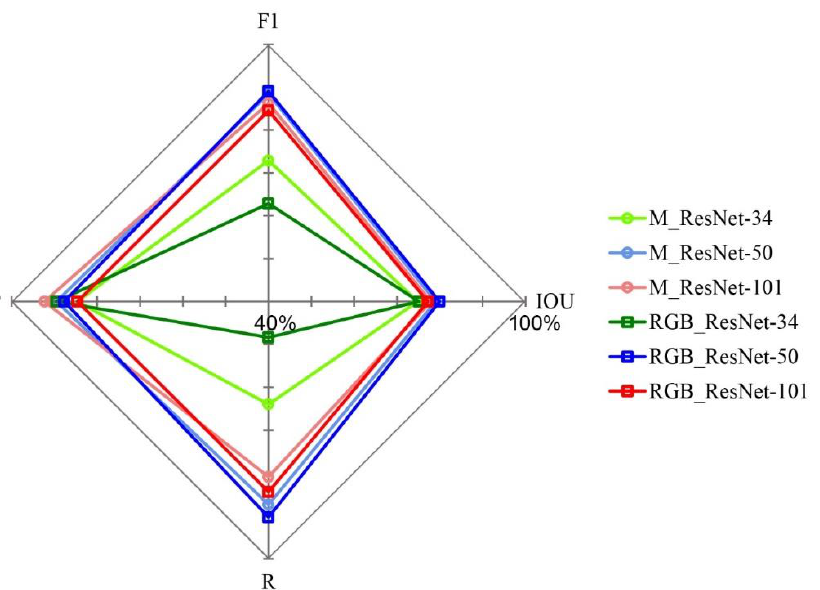
Figure 5. The detection accuracy of Fokienia hodginsii using Mask R-CNN with three different backbones (ResNet-34, ResNet-50, and ResNet-101). The same number of training samples (1689 tree crowns) and two input images (RGB image and Multi-band image) were used as input into the model, and other parameters were kept the same. The accuracy was achieved using ResNet-34 with the Multi-band image, which is highlighted in light green, ResNet-34 with the RGB image is in dark green, ResNet-50 with the Multi-band image is in light blue, ResNet-50 with the RGB image is in dark blue, ResNet-101 with the Multi-band image is in light red, and ResNet-101 with the RGB image is in dark red. R, P, F1, and IoU represent recall, precision, F1 score, and Intersection over Union, respectively.